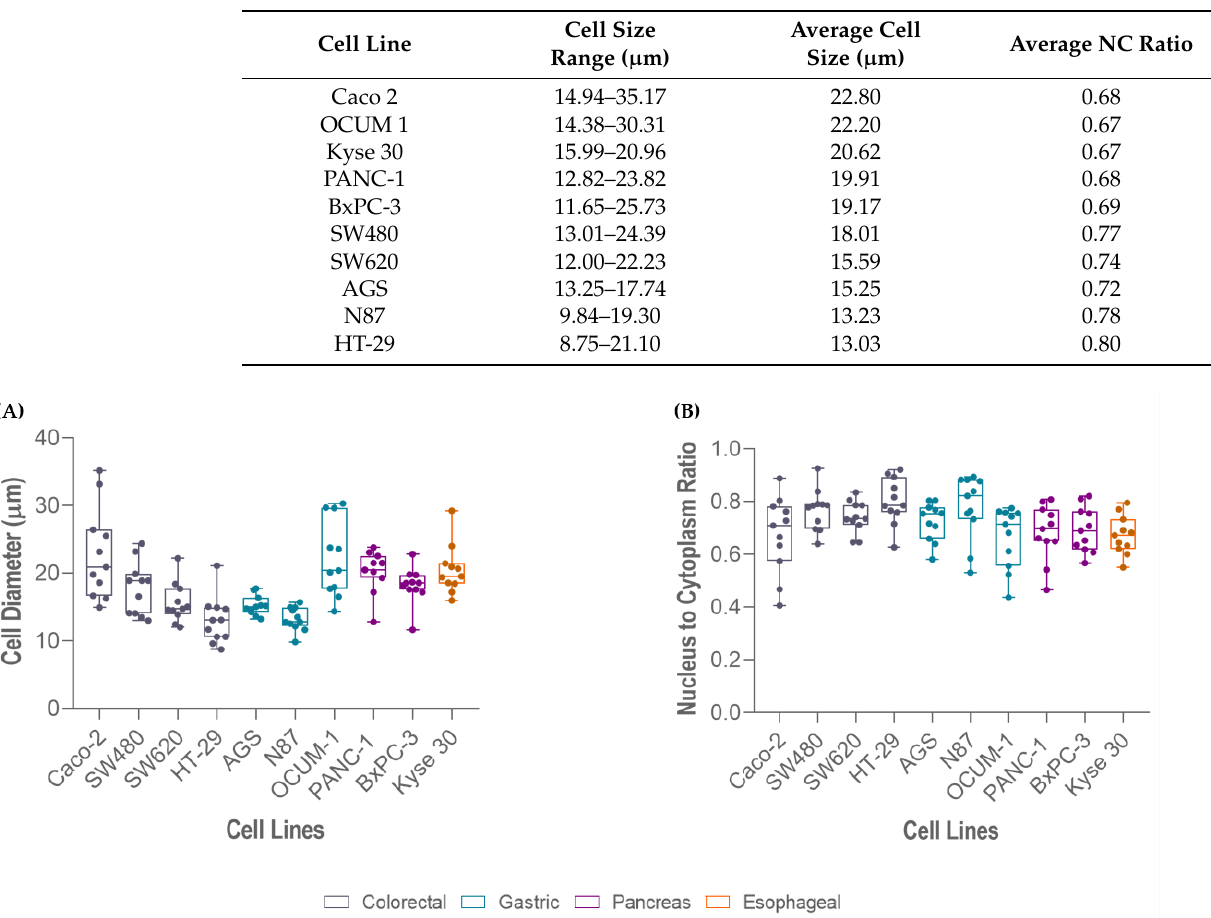
Table 1. Cell dimensions of each gastrointestinal cancer cell lines (cell size range, average cell size and average NC ratio, N = 10).